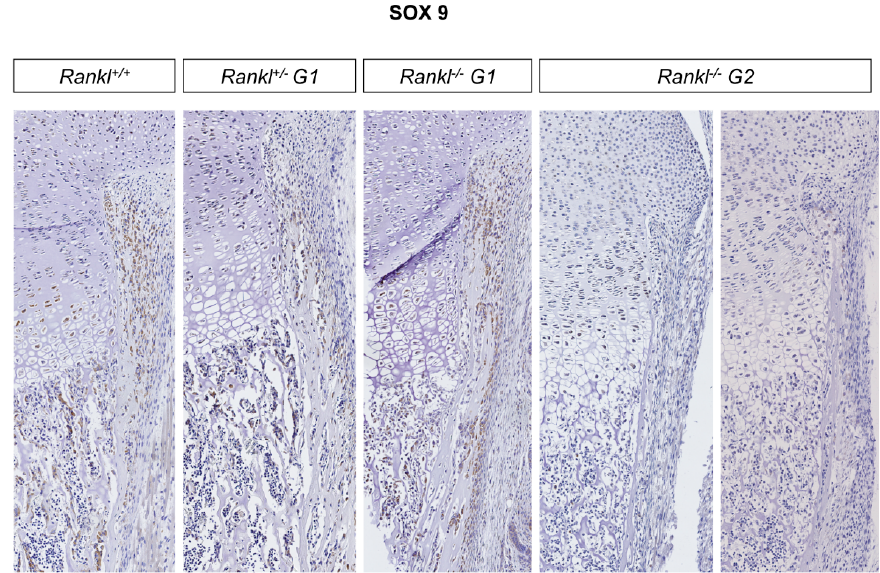
Figure 5. Immunohistochemical comparative analysis of SOX9 expression in the tibias of first- and second-generation Rankl null mutant mice. A graduated decrease in SOX9 expression was observed from wild type to first-generation null mutant pups in either chondroblastic cells or periosteal osteoblastic cells. In the tibias of second-generation null mutant pups, very weak staining was present in rare chondroblastic cells, while no staining was observed in periosteal osteoblastic cells. Magnification 100×. Numbers of pups: 4 +/+, 8 G1+/ − , 5 G1 − / − , and 5 G2 − / − . 3.3. IK22-5 RANKL-Blocking Antibody Injections in Pregnant Heterozygous Mice Induced a Second- Generation-Like Phenotype in Null Mutant Pups In order to validate the importance of RANKL of maternal origin in the attenuated osteopetrotic phenotype of the null mutant pups, IK22-5-blocking antibody was injected into heterozygous pregnant females during the second part of gestation, and the consequences on the whole skeleton of the pups were analyzed (Figures 6 and 7). A noticeable aggravation in either craniofacial or long bone phenotypes was observed for the different genotypes, with WT being comparable to first-generation heterozygous mutants and first-generation to second-generation null mutants. Surprisingly, while a more open foramen (Figure 6) and severe tooth morphogenesis delay (Figure 7) was observed in the null mutants from injected mothers, the curvature of the mandible appeared unaffected (Figure 6), suggesting that this craniofacial osteopetrotic feature was secondary to a loss of RANKL function before mid-gestation.